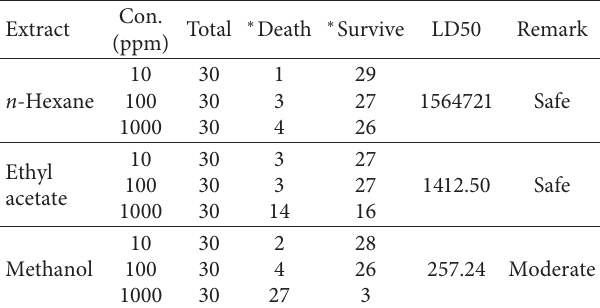
Table 5: The effects of different concentrations of n-hexane, ethyl acetate, and methanol extracts on Culex quinquefasciatus mosquito larvae mortality